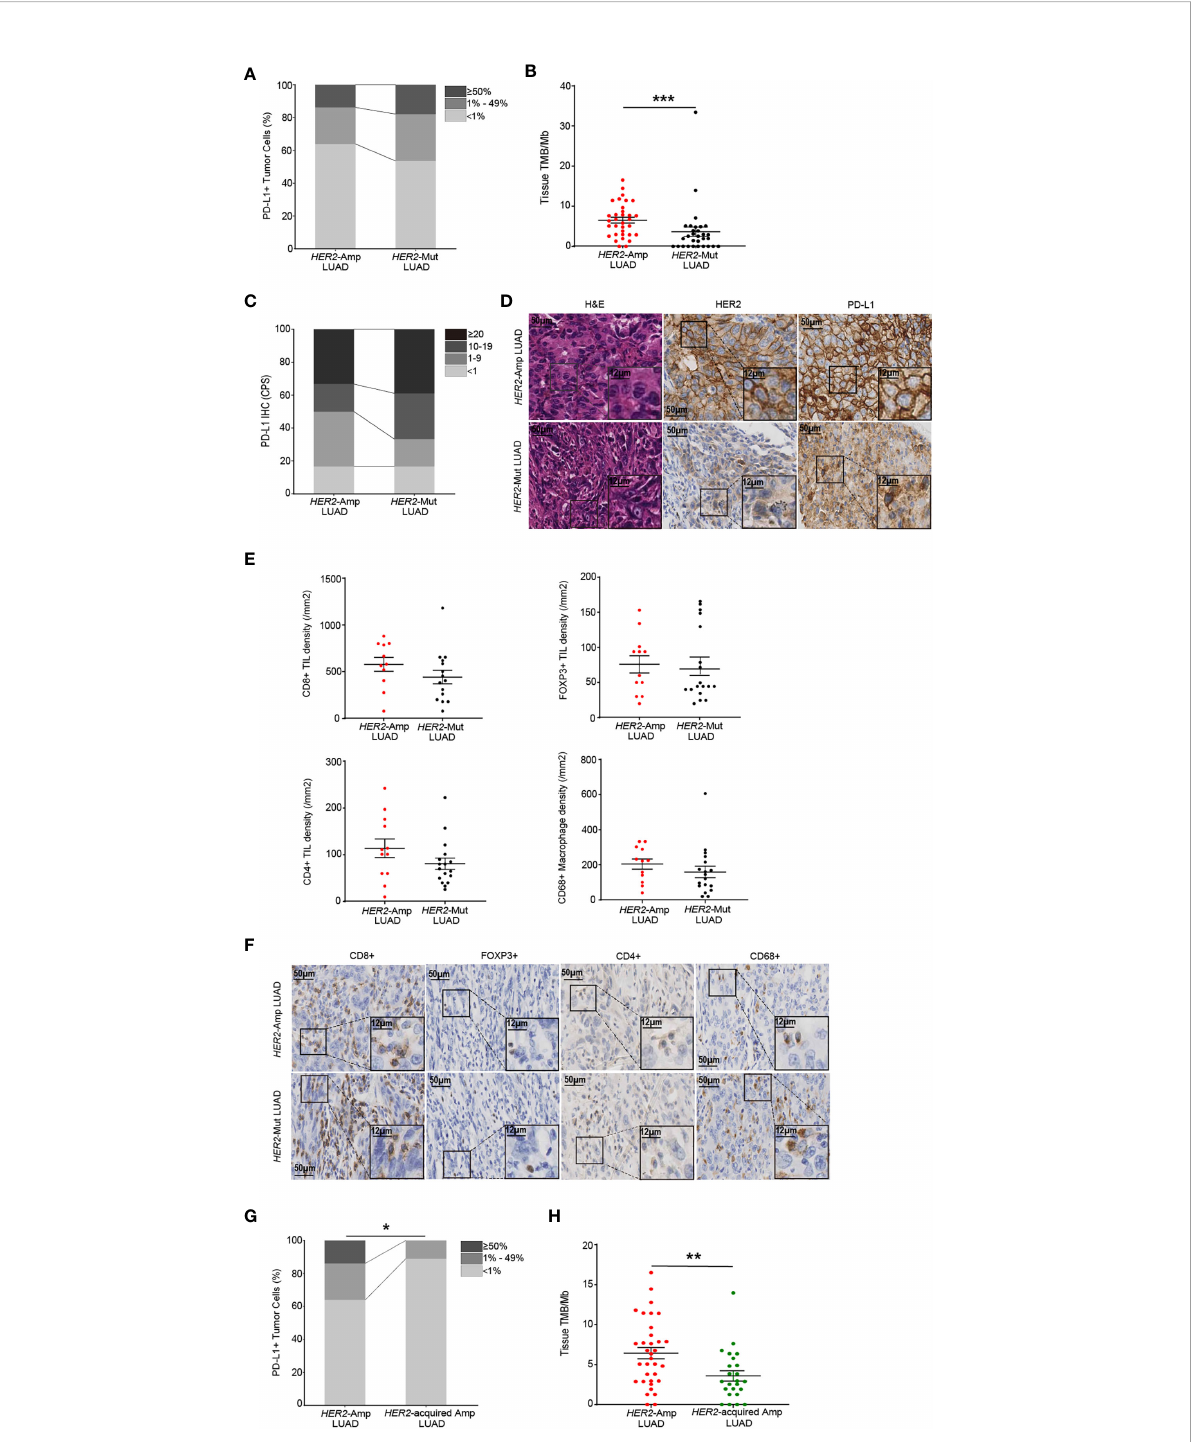
FIGURE 4 The immunogenicity and TIME in HER2 -aberrant LUAD. (A, B) Difference in PD-L1 expression on tumor cells (A) and the level of TMB (B) between ampli fi cation and mutation. (C, D) Statistical results (c) and images (D) of PD-L1 expression evaluated by CPS. (E, F) Densities of CD8 + , POXP3 + and CD4 + lymphocytes, and CD68 + macrophages (E) between LUAD patients with HER2 ampli fi cation (n=12) and mutation (n=18). Corresponding IHC images are shown in (F) . Note: The paraf fi n section of 3 patients with HER2 -mutant LUAD failed the quality control after CD8 IHC staining and were not included in the statistical analysis. 1 patient with HER2 -mutant LUAD was not included after CD4 IHC staining because of the same problem. (G, H) The PD-L1 (G) and TMB (H) levels in LUAD patients with HER2 ampli fi cation and acquired HER2 ampli fi cation. P < 0.05 was regarded as signi fi cantly different. *** P < 0.001, ** P < 0.01, * P <